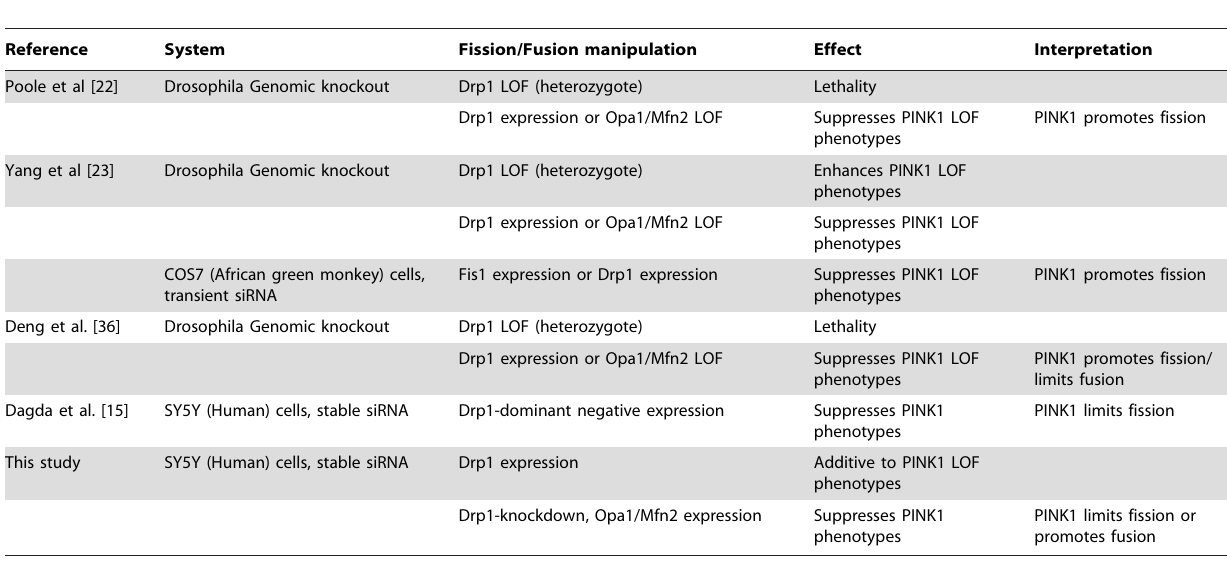
Table 1. Effects of mitochondrial fusion and fission proteins on PINK1 phenotypes in different